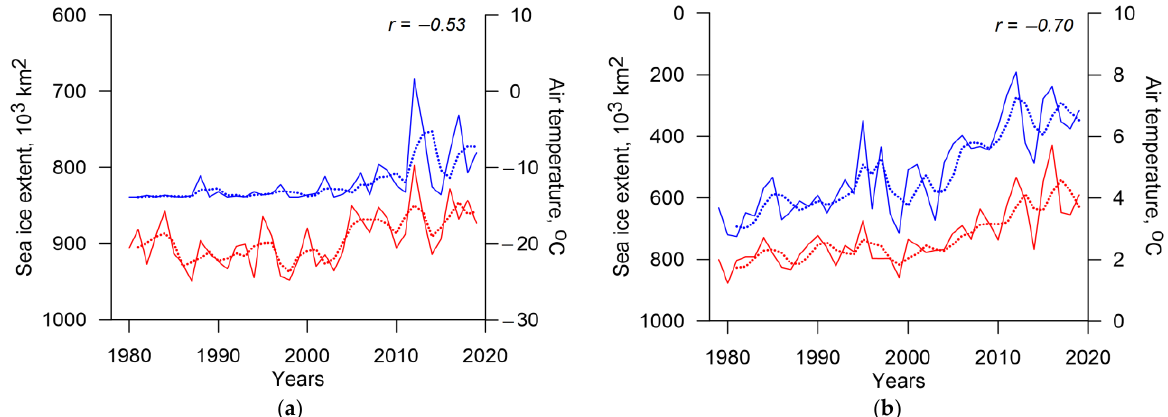
Figure 2. ( a ) Surface air temperature (red) and sea ice extent (blue, axis reversed) in December–February and ( b ) surface air temperature (red) and sea ice extent (blue, axis reversed) in June–August in the Kara Sea from 1979 to 2019 according to ERA5 reanalysis. Dotted line—after smoothing with 3-year window, r—correlation coefficient after removal of the trend. Table 1. Linear trends of surface air temperature (SAT, °С/year) and sea ice extent (SIE, 10 3 km 2 /year) in the Kara Sea. SAT SIE Period